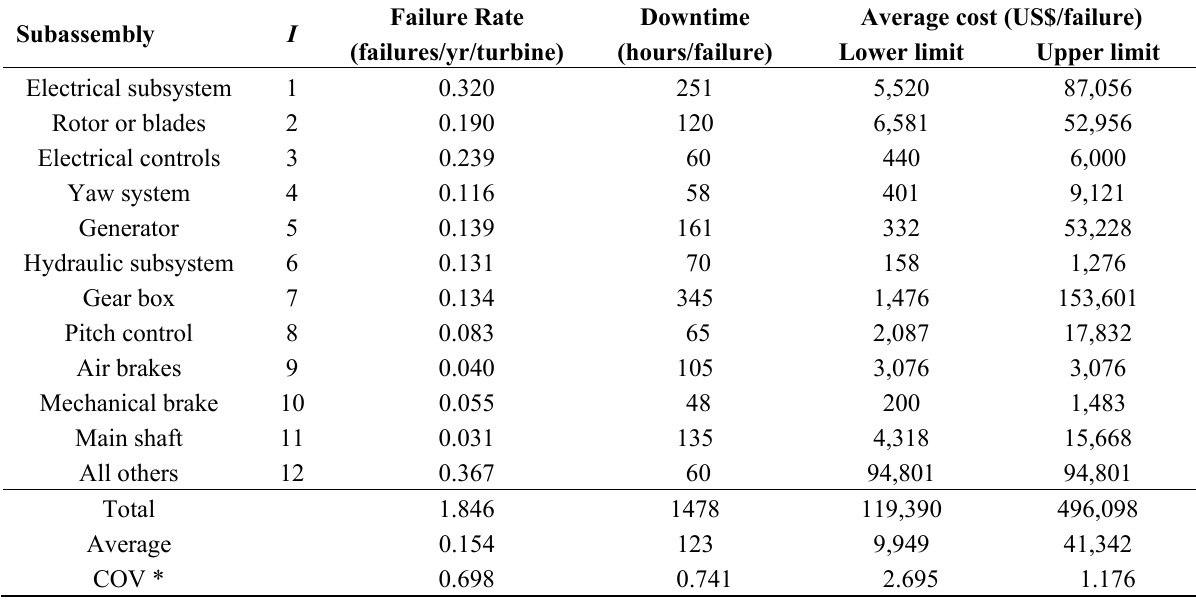
Table 1. Failure data for 12-subassembly wind turbine system